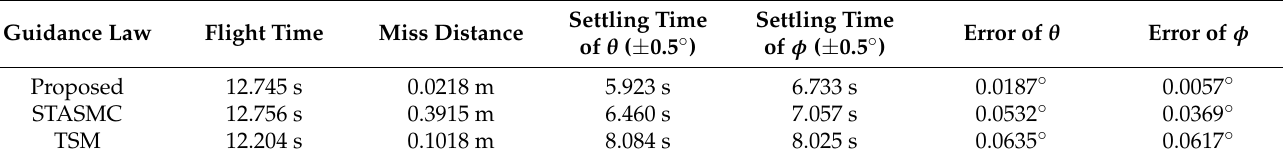
Table 3. Simulation results of scenario 1.